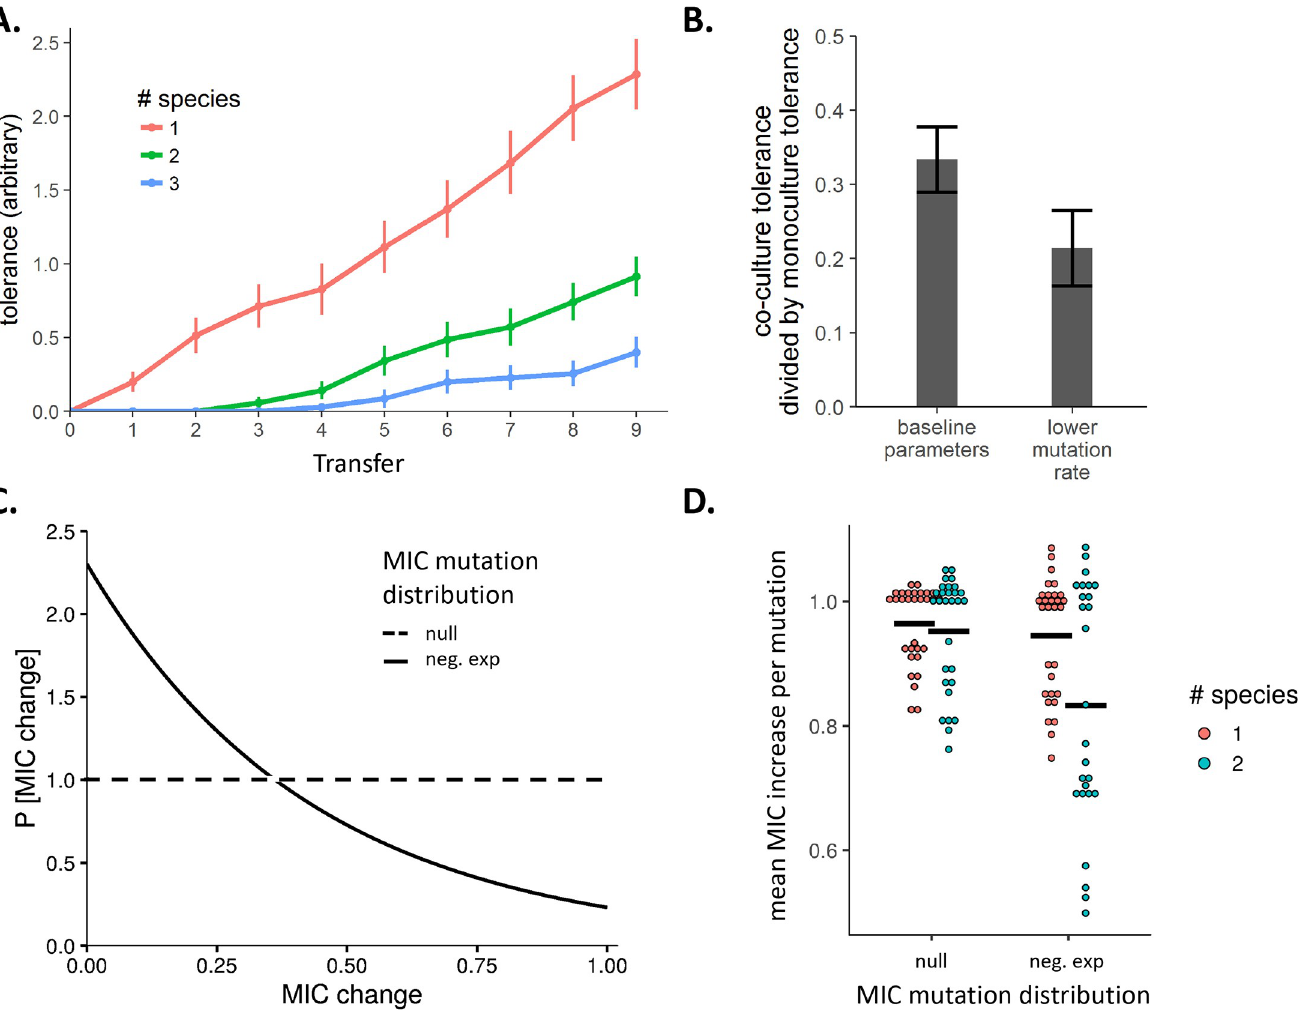
Fig 5. Simulation model of the evolution of antibiotic resistance in single-species vs. multi-species obligately dependent communities. A. A simulated evolution experiment with 35 replicate populations shows that increasing the number of interdependent species in a consortium results in a slower increase in the average MIC over time. Error bars represent the standard deviation among replicates. B. Effect of lower mutation rate on resistance evolution in model. Lower mutation rates result in bigger differences in the relative tolerance of one-species versus two species systems. C. Distributions from which MIC-altering mutations were randomly pulled. The x-axis is relative to the maximum MIC change possible in one mutation. The “null” model used a uniform distribution. The “neg exp” used a truncated negative exponential distribution with rate parameter 2.3, which kept 90% of random numbers less than the max MIC change of 1.0. D. Mean MIC increase conferred per mutation as a function of the mutation distribution and the number of